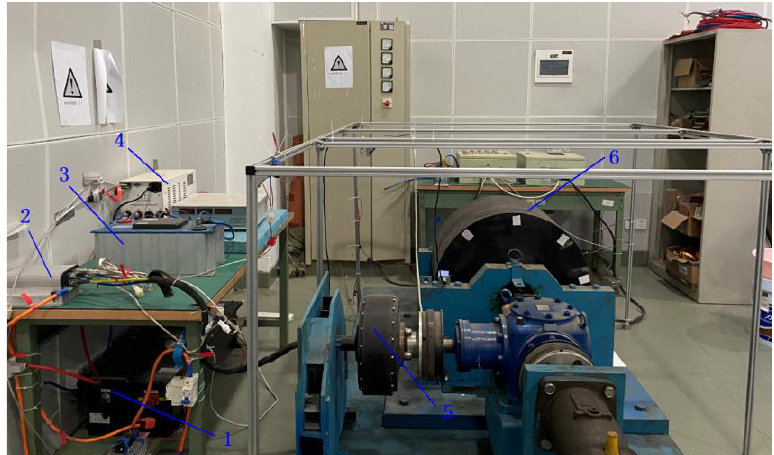
Figure 3. HERBS test-bench. 1. power batteries 2. motor controllers 3. supercapacitors 4. bidirectional DC/DC converters 5. brushless DC motors 6. flywheel.